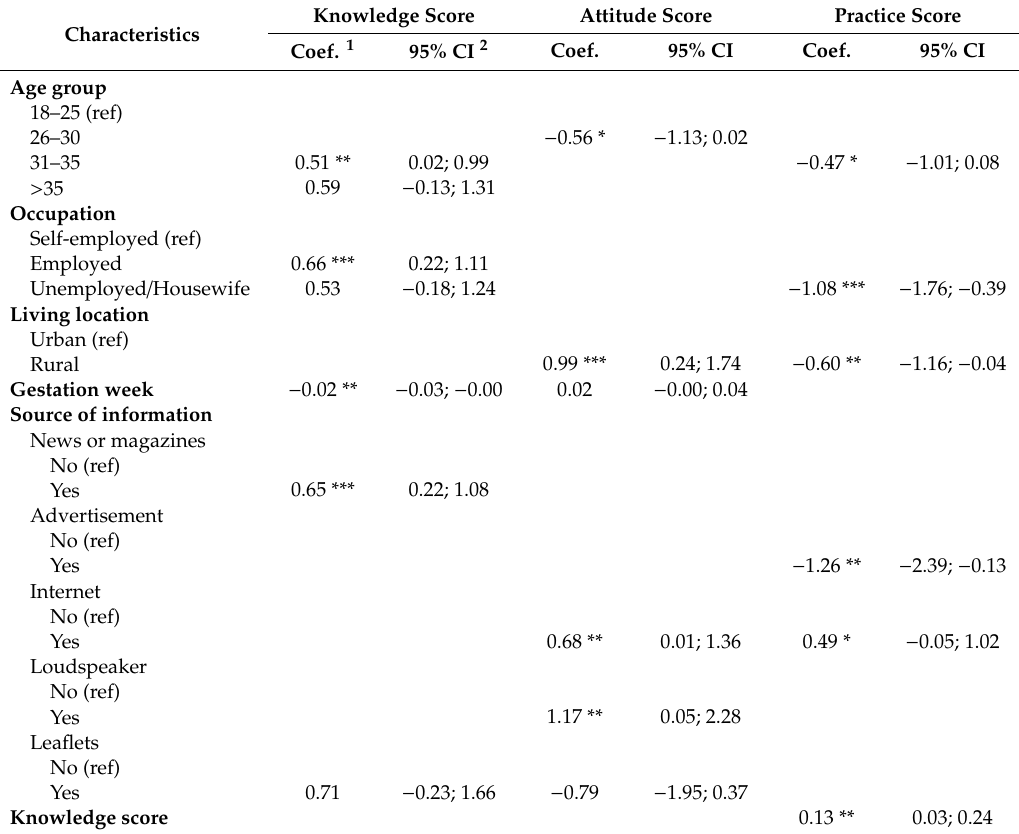
Table 5. Associated factors with knowledge, attitude and